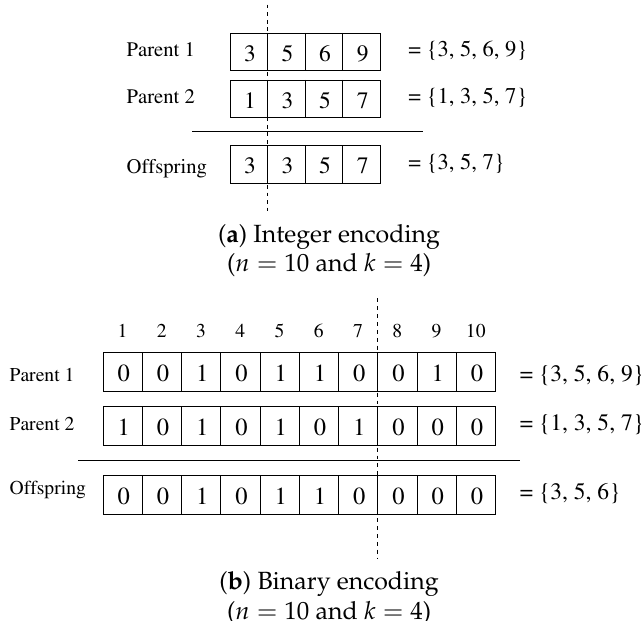
Figure 2. How infeasible solutions can be created by crossover